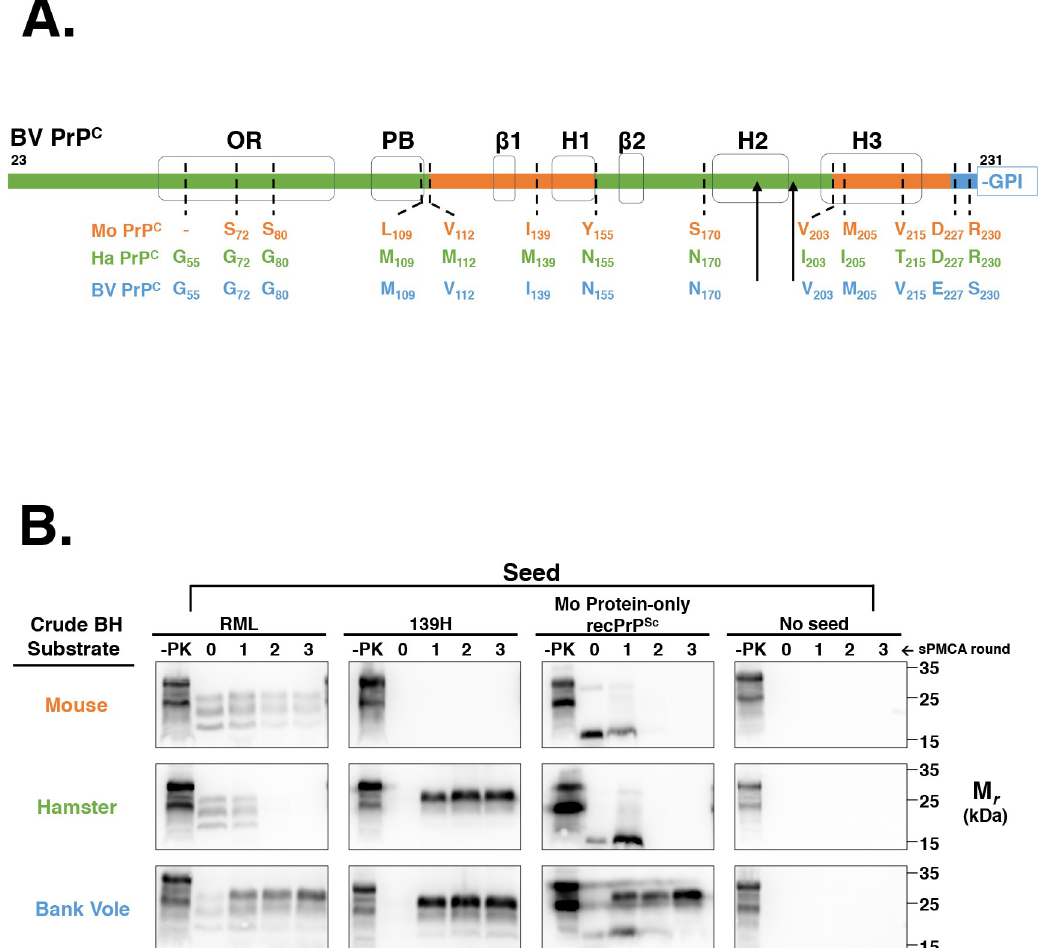
Fig 1. Susceptibility of various rodent species in BH sPMCA. (A) Amino acid comparison of the processed regions of Mo PrP, Ha PrP, and BV PrP. The sequence bar highlights the regions of BV PrP homologous to Mo PrP (orange) or Ha PrP (green), or are unique to BV PrP (blue). Black arrowheads denote the location of N-linked glycans. The locations of various structural domains are shown in black. OR = octapeptide repeat; PB = polybasic domain; GPI = glycophosphaditylinositol. Sequence alignments were performed using Multalin[25]. (B) Western blots showing three-round sPMCA reactions using normal brain homogenates (BH) from the species used in (A) as the substrates and initially seeded on day 0 with various seeds, as indicated. Day 0 samples are seeded reactions not subject to sonication. -PK = samples not subjected to proteinase K digestion; all other samples were proteolyzed.